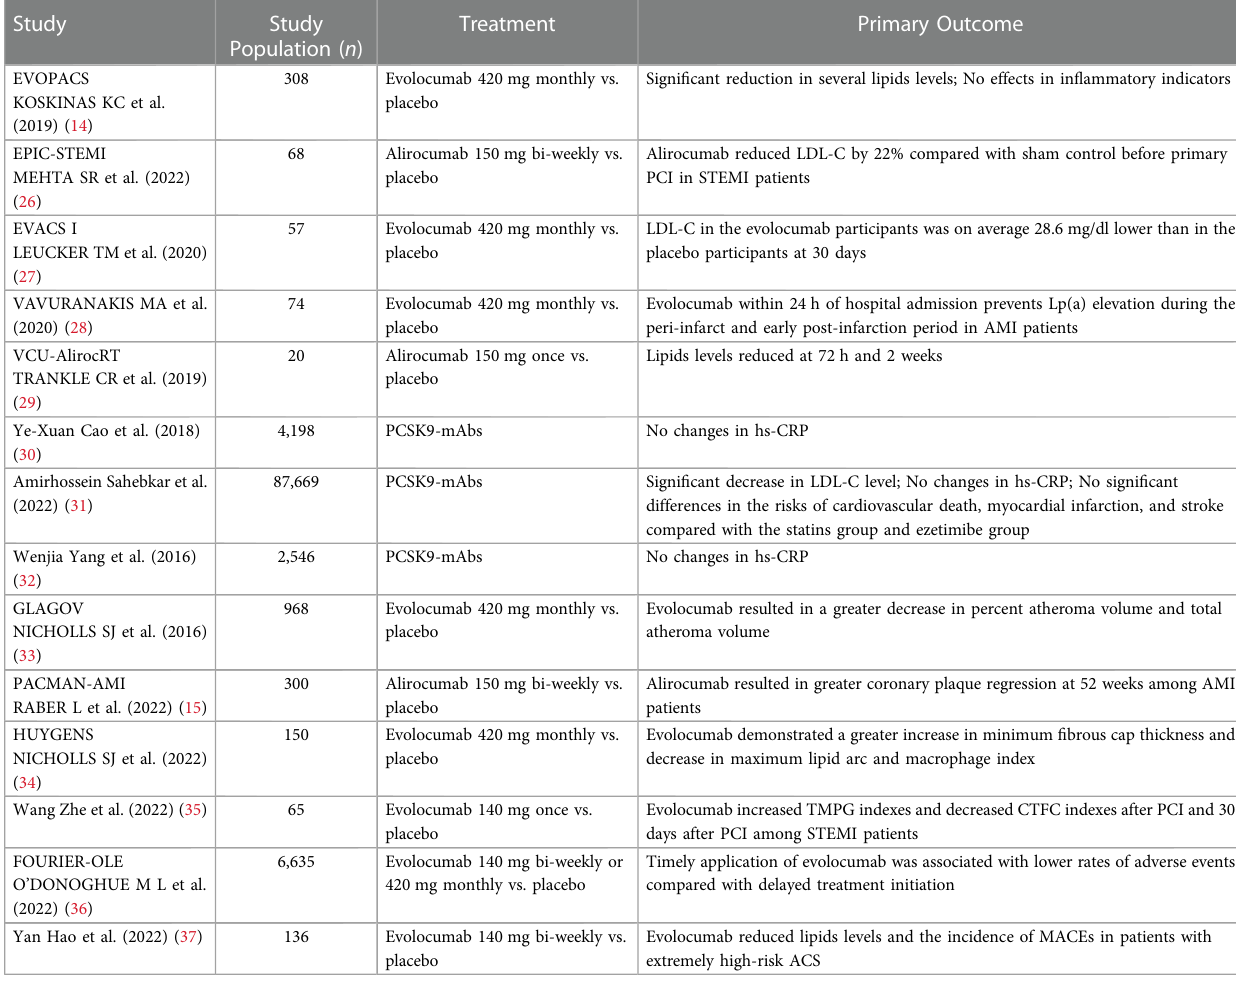
TABLE 1 Studies that have evaluated the effects of